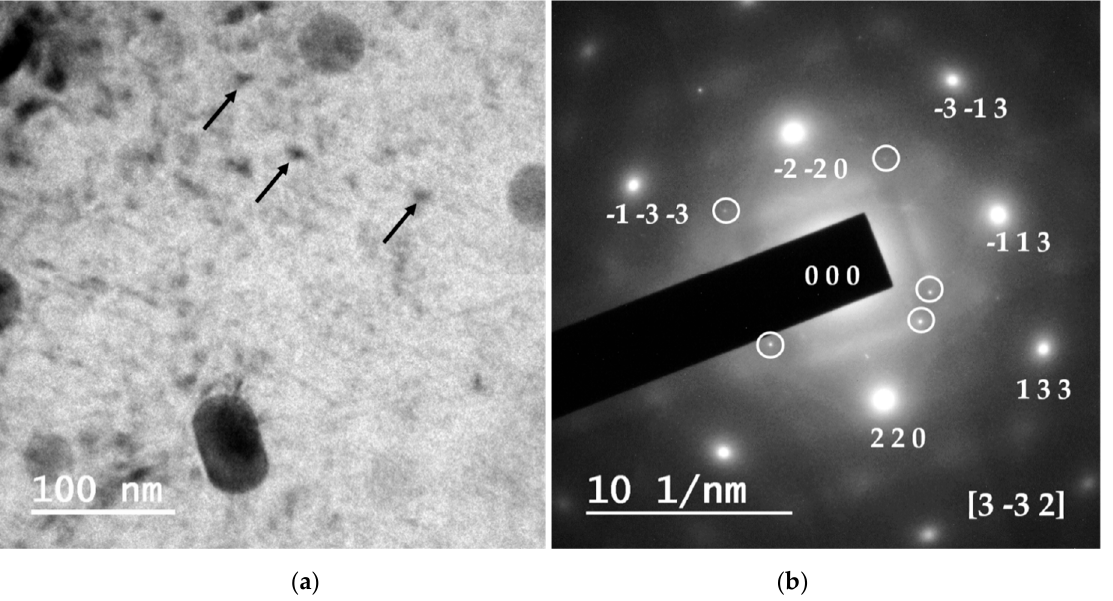
Figure 7. A transmission electron microscopy (TEM) bright-field image ( a ) and selected area diffraction (SAD) pattern ( b ) of an extruded profile at 500 ° C from compacted AA 6005A powders specimen aged at 180 ° C for 6 h (peak-aging hardness condition).